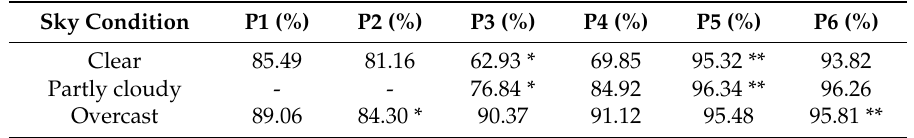
Table 6. Prediction accuracy of the daylight illuminance on the workplane for points P1–P6 according to the sky conditions.